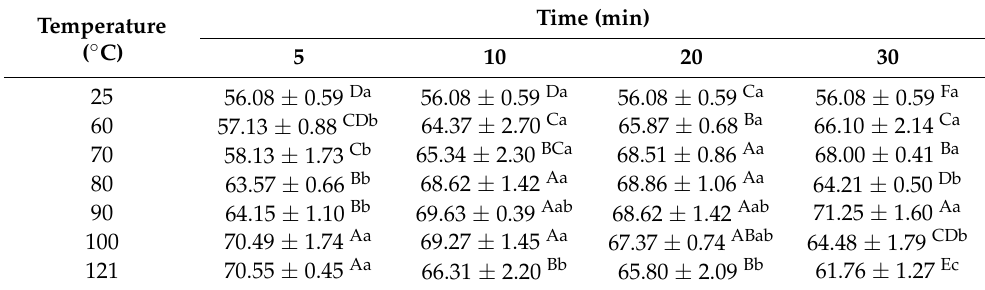
Table 4. Effects of different hydrothermal treatment conditions on the emulsion stability, %. A–F indicates the significant differences between different temperatures and a–c indicates the significant differences between different times ( p <